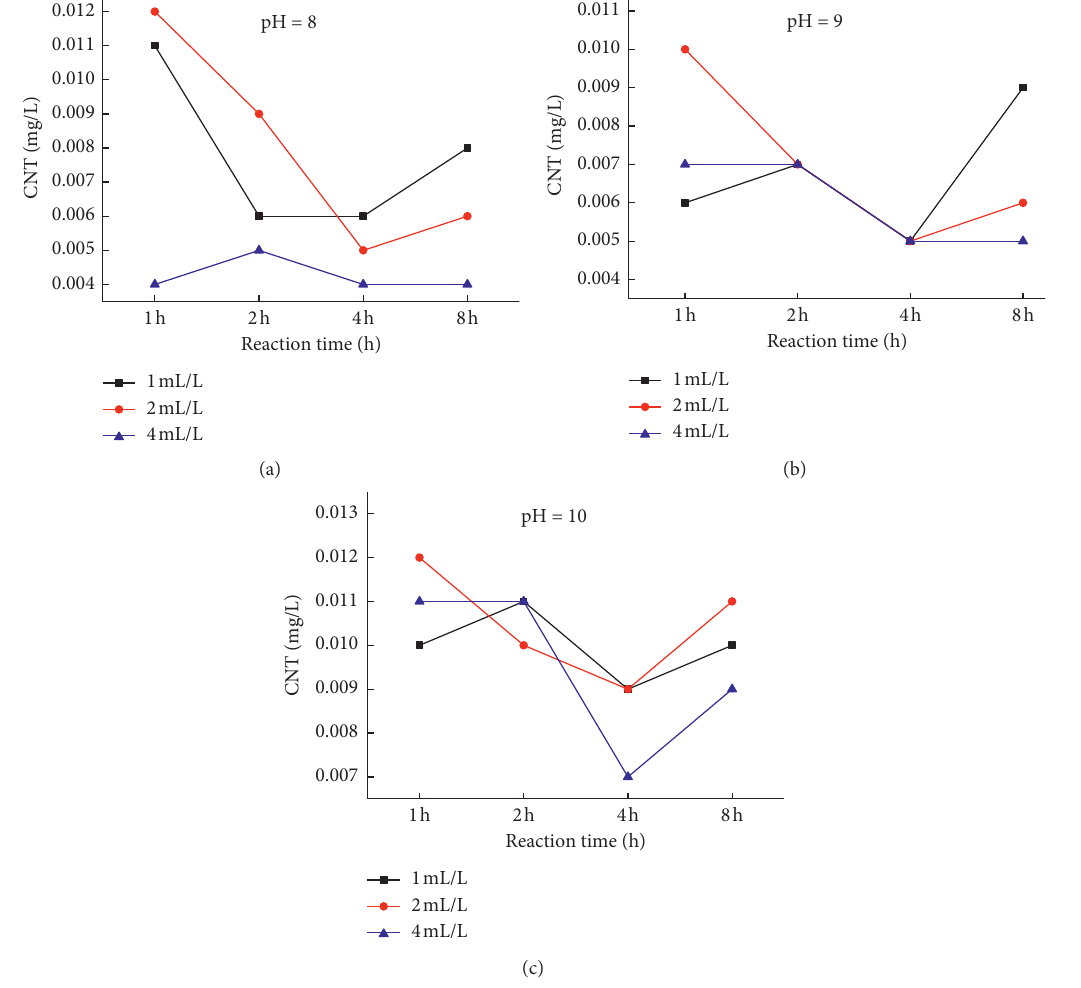
Figure 4: Cyanide as a function of contact